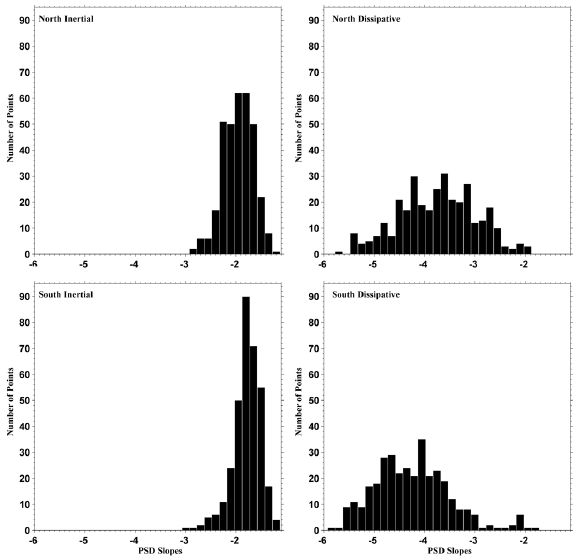
Fig. 4. Distribution of spectral indices. Shown are histograms of the power spectral indices for the inertial range during northward IMF (top left), the dissipative range for northward IMF (top right), the inertial range during southward IMF (bottom left) and the dissi- pative range for southward IMF (bottom